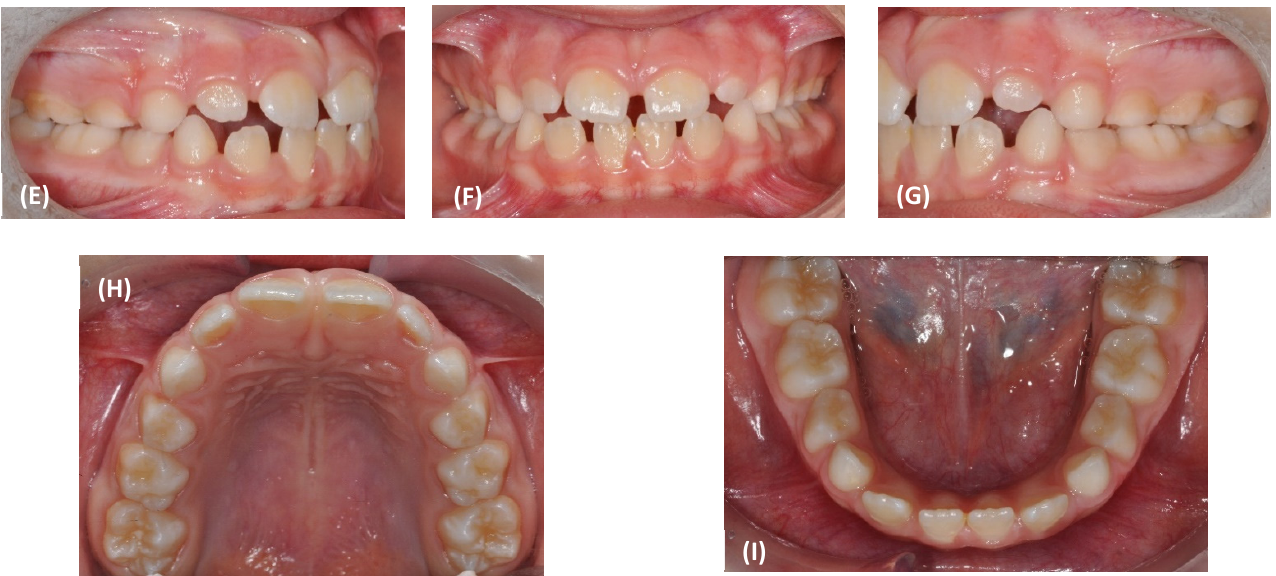
Figure 1. ( A – D ) Pretreatment facial photographs. ( E – G ) Pretreatment intraoral frontal and lateral photographs. ( H , I ) Pretreatment occlusal upper and lower arch photographs. Intraorally, she presented with a mild Class III dental relationship in the mixed dentition and minimal overjet, despite the proclination of the upper incisors as a dental compensation (Figure 1E–G). A constriction of the maxillary arch was also evident from the occlusal photograph (Figure 1H,I). The panoramic radiograph revealed a discrepancy between the space available and the space requested for the eruption of the permanent teeth, particularly in the canine area (Figure 2).